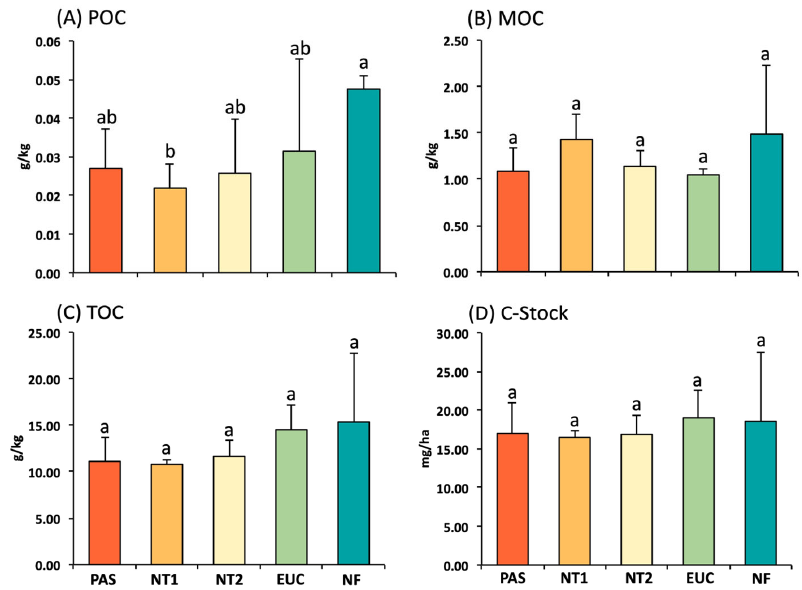
Figure 3. Particulate organic carbon (POC) ( A ), mineral organic carbon (MOC) ( B ), total organic carbon (TOC) ( C ), and carbon stock (C-Stock) ( D ) in the 0-0.10 m depth. Vertical lines on the bars indicate standard errors of means ( n = 5). Treatments with different letters on the bars are significantly different ( p ≤ 0.05) by the Tukey test. PAS: Pasture species (Mombasa); NT1 and NT2: No-tillage system; EUC: Eucalyptus; and NF: Native Cerrado forest.